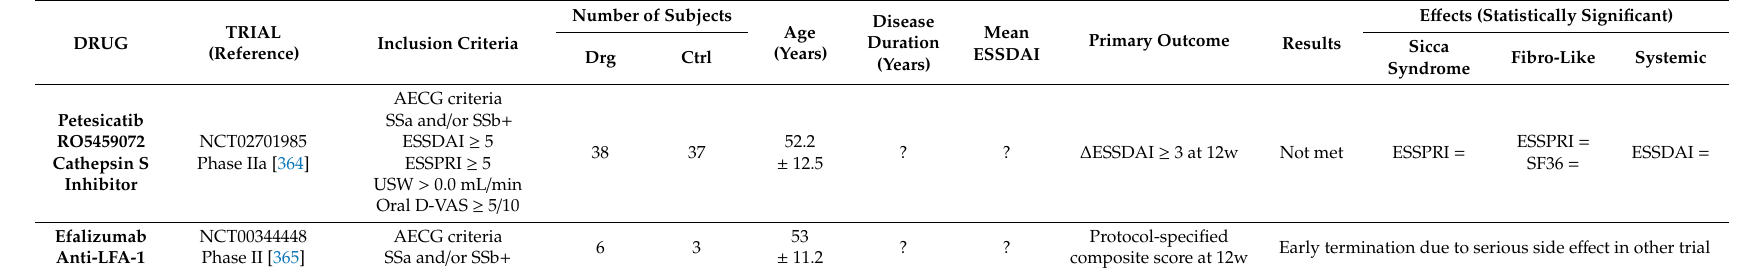
Table 10. T-cell targeted drugs in pSS: therapies preventing autoantigen presentation.